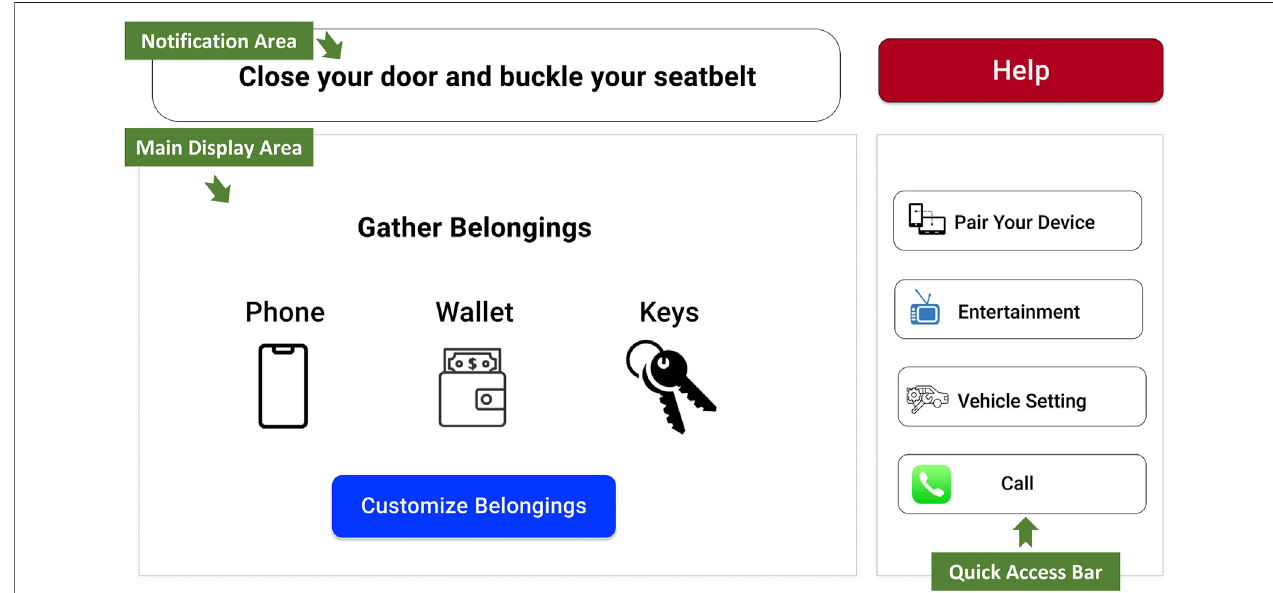
FIGURE 1 | Prototype of the in-vehicle interface.